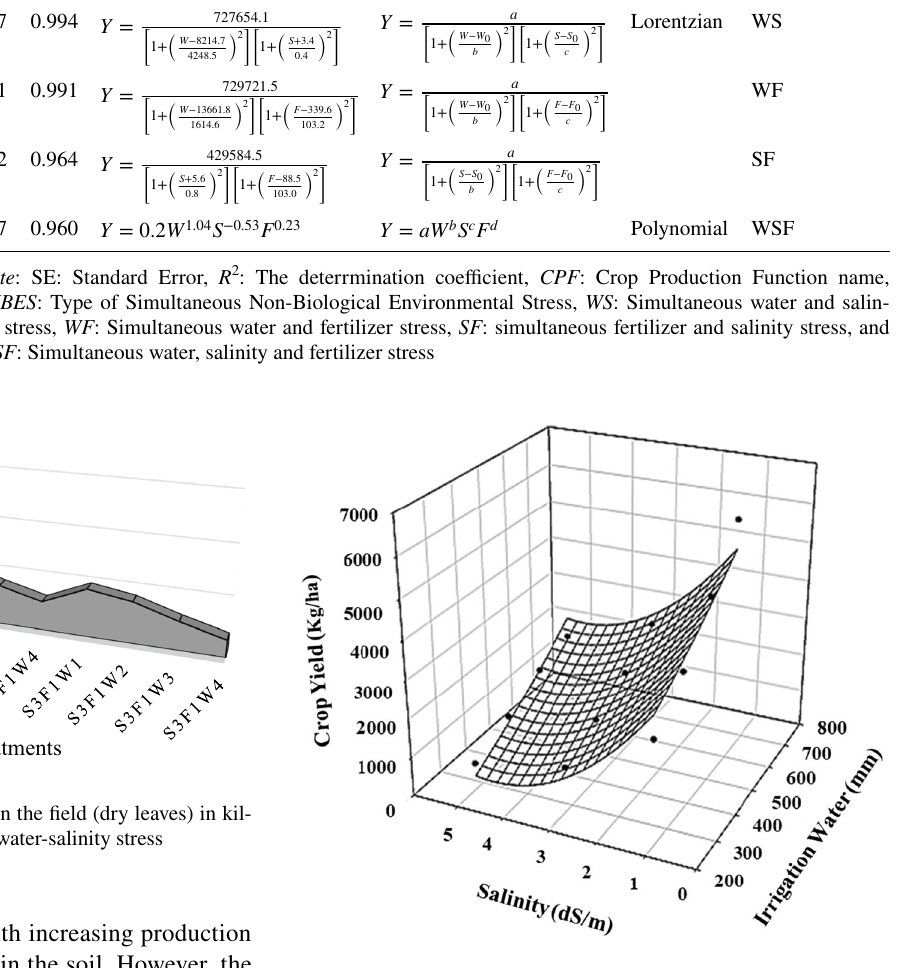
* And **: Significant at the levels of 1% and 5%, Table 8 Basil plant production functions in dual and triple stresses of water, salinity, and fertilizer